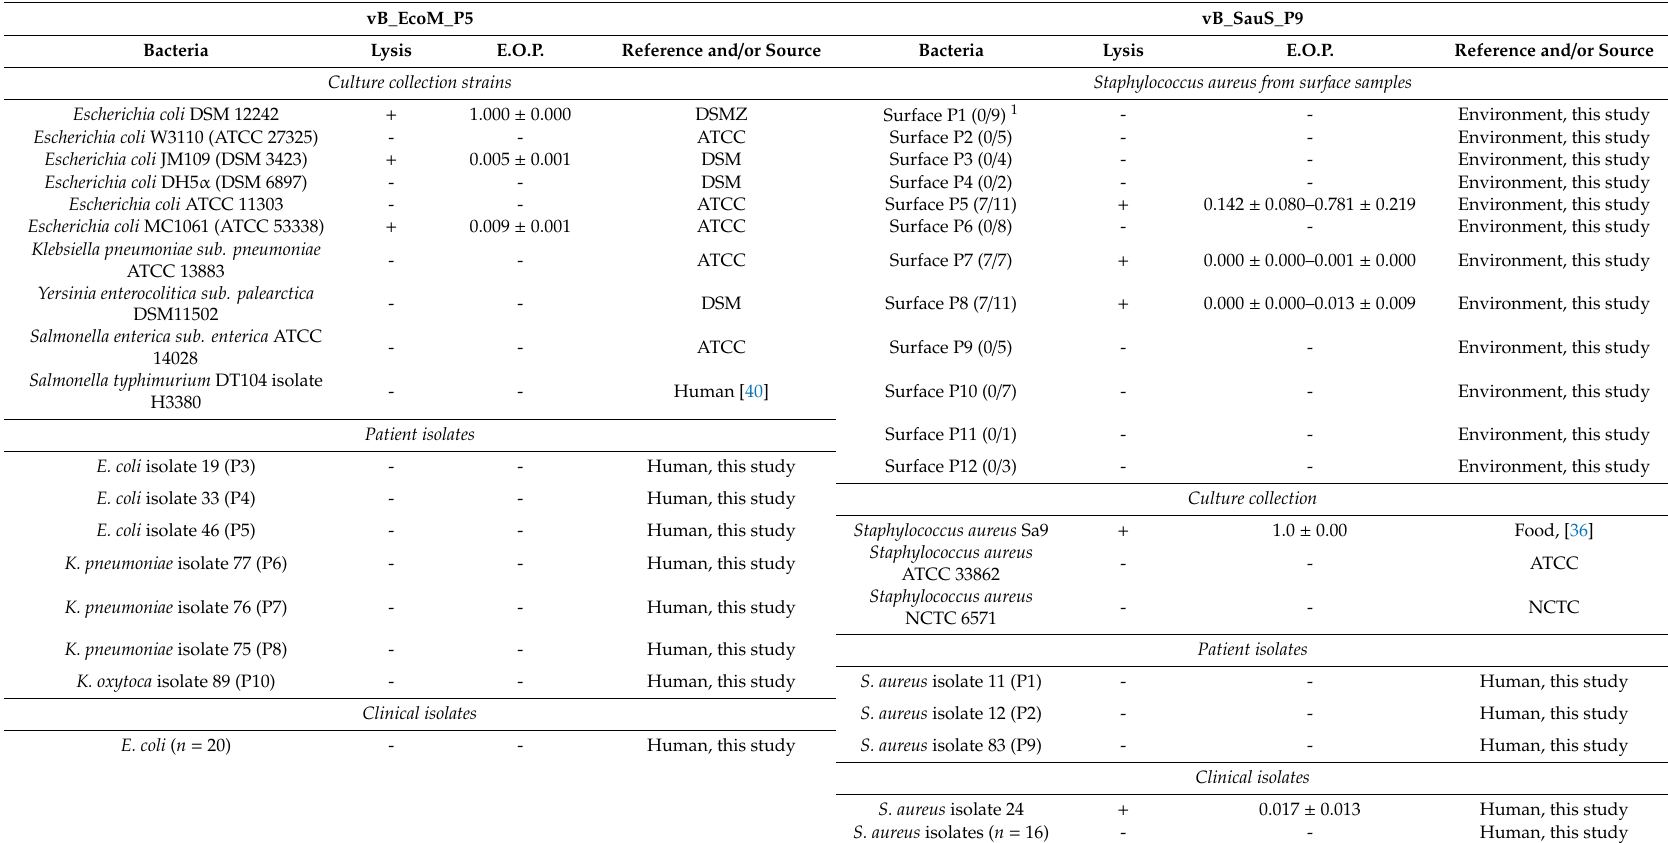
Table 3. Antimicrobial activity of temperate phages vB_EcoM_P5 and